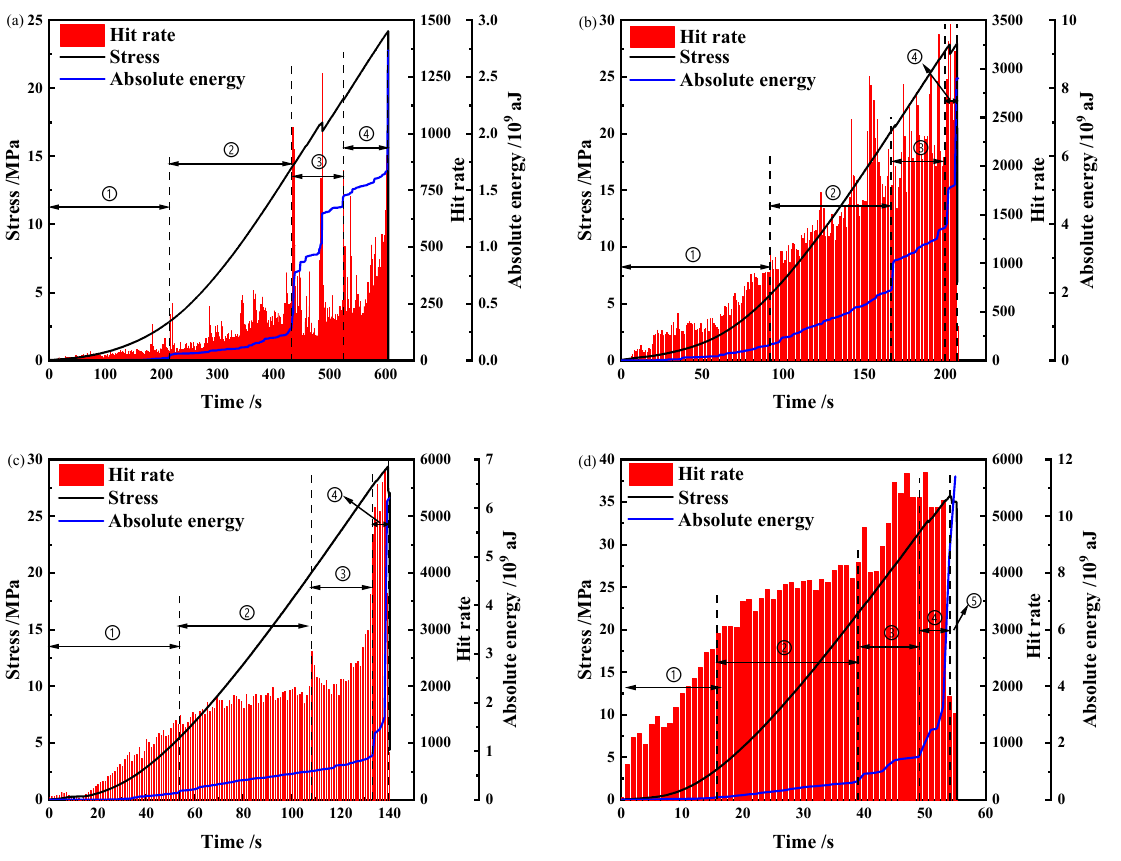
Figure 6. Evolution of stress, hit rate, and absolute energy with time under different loading rates: ( a ) 0.2 mm/min, ( b ) 0.6 mm/min, ( c ) 1.0 mm/min, and ( d ) 3.0 mm/min. ① crack compaction phase, ② crack initiation phase, ③ stable crack growth phase, ④ unstable crack growth phase, and ⑤ post-peak failure phase.